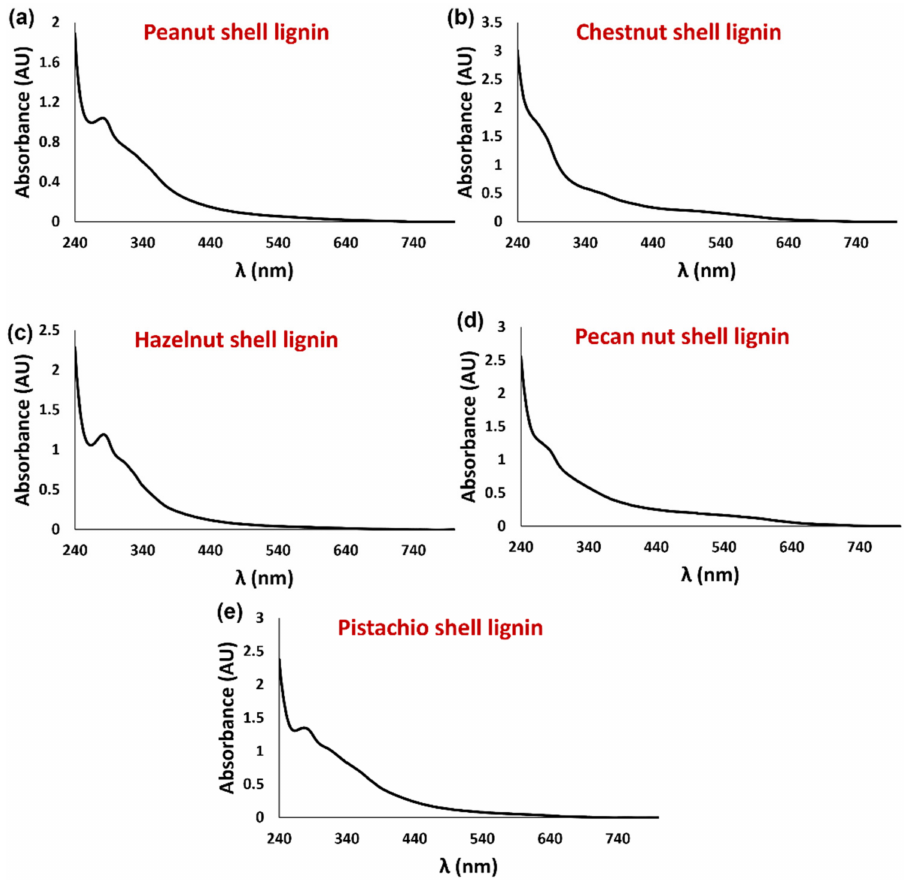
Figure 2. UV-Vis spectra of the DMSO-soluble fraction of ( a ) peanut, ( b ) chestnut, ( c ) hazelnut, ( d ) pecan nut, and ( e ) pistachio shell lignins.